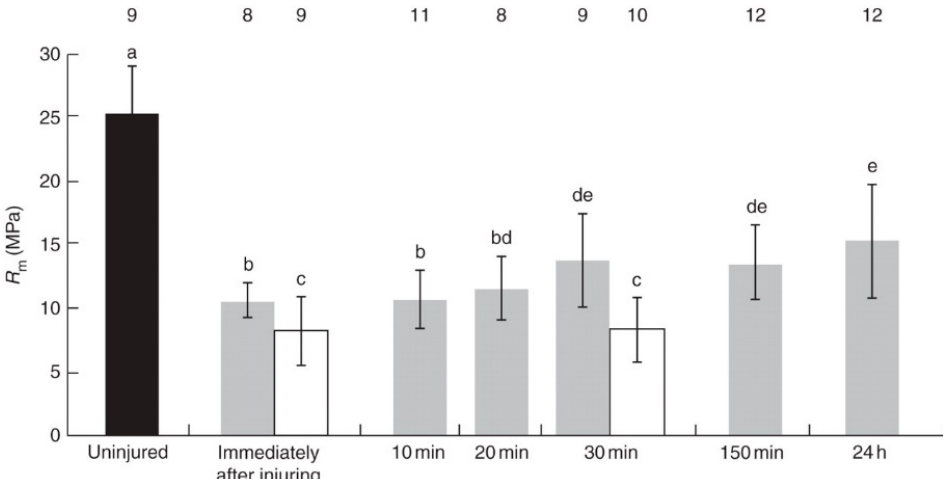
Figure 9. Self-sealing and self-healing in barks of Ficus benjamina . Tensile strength ( R m ) of uninjured bark (black columns) and at various times after damage (grey columns). White columns represent bark samples from which latex was cleaned immediately after injury. Numbers of samples tested are indicated above. Results marked with the same letter do not differ significantly. Reproduced from [73], by permission of Oxford University Press on behalf of the Annals of Botany Company.